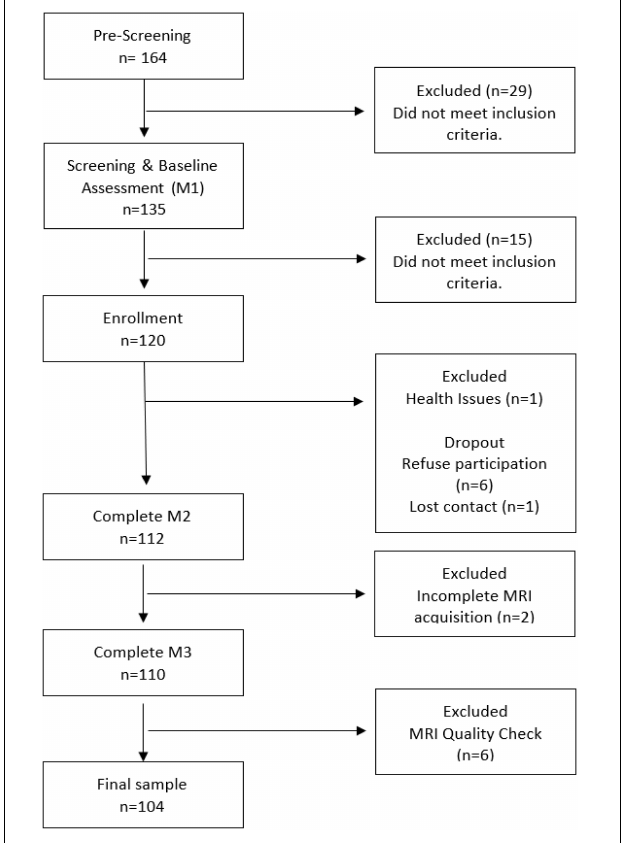
FIGURE 2 | Flow diagram of participant screening and